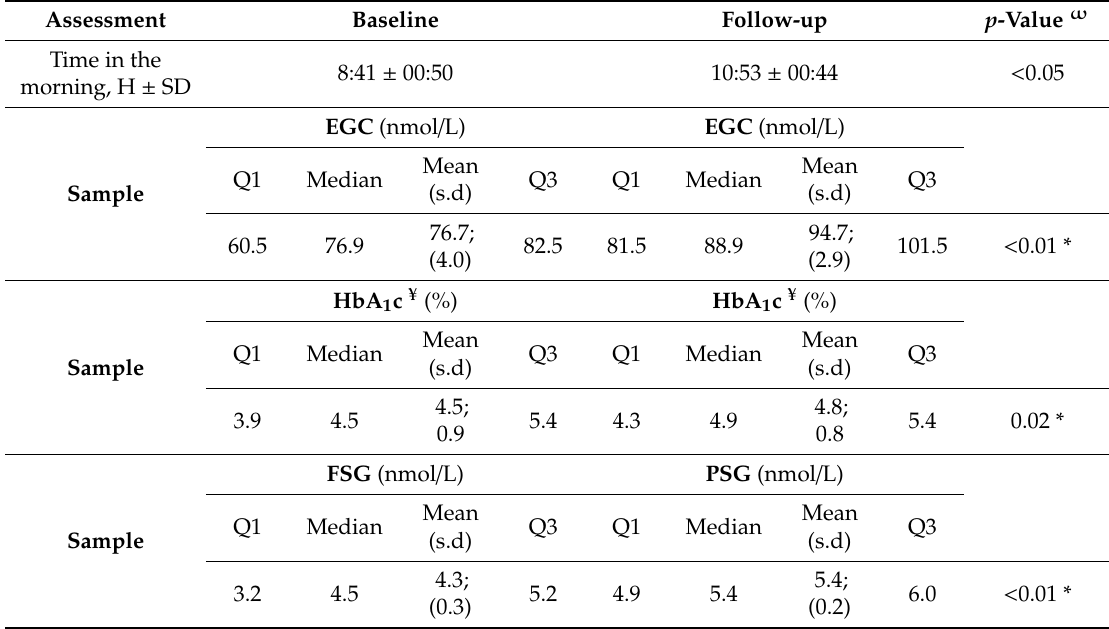
Table 4. Baseline and follow-up glycemia, HbA 1c , EGC, and time comparisons.